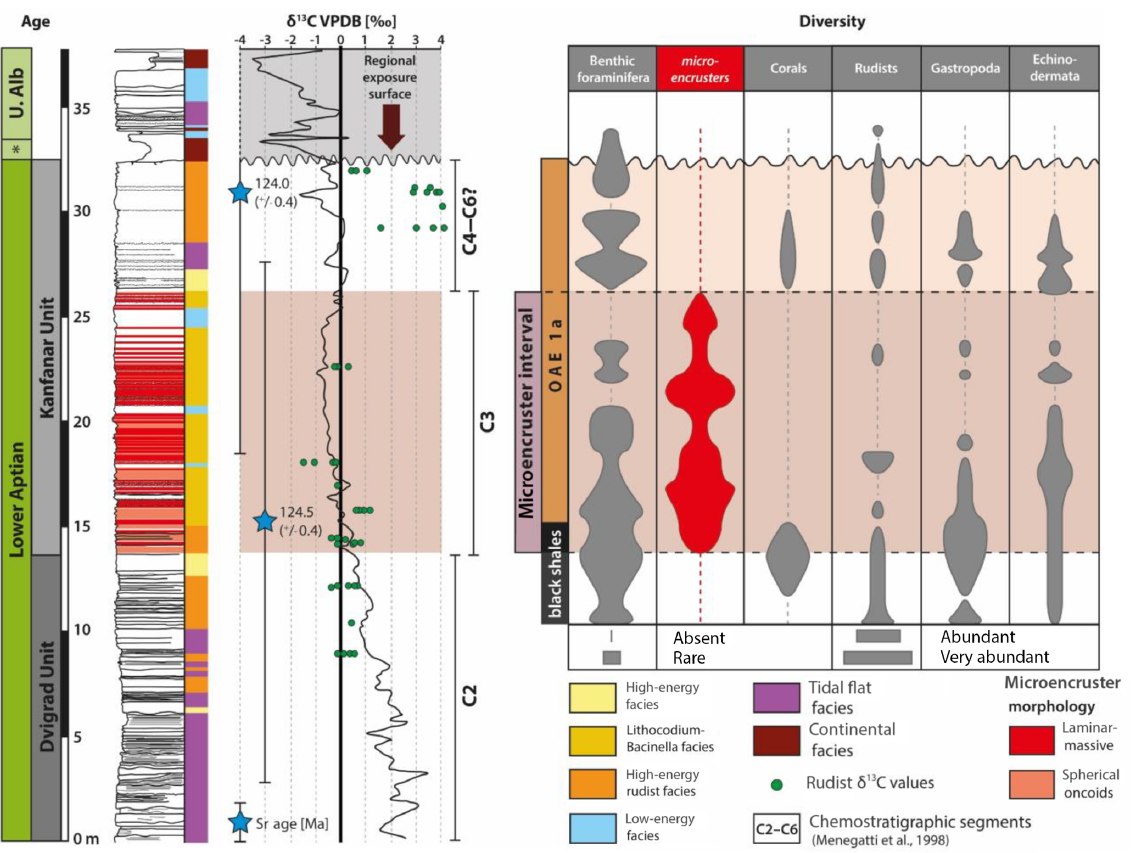
Figure 3. Stratigraphic frequency distribution of marine carbonate-secreting organisms in the Dvigrad and Kanfanar units based on thin section analysis. Stratigraphic framework and δ 13 C (including Sr age) isotope stratigraphy from Huck et al. (2010). OAE 1a-equivalent interval and microencruster facies are indicated. Chemostratigraphic segments (C2 through C6) are based on Menegatti et al.